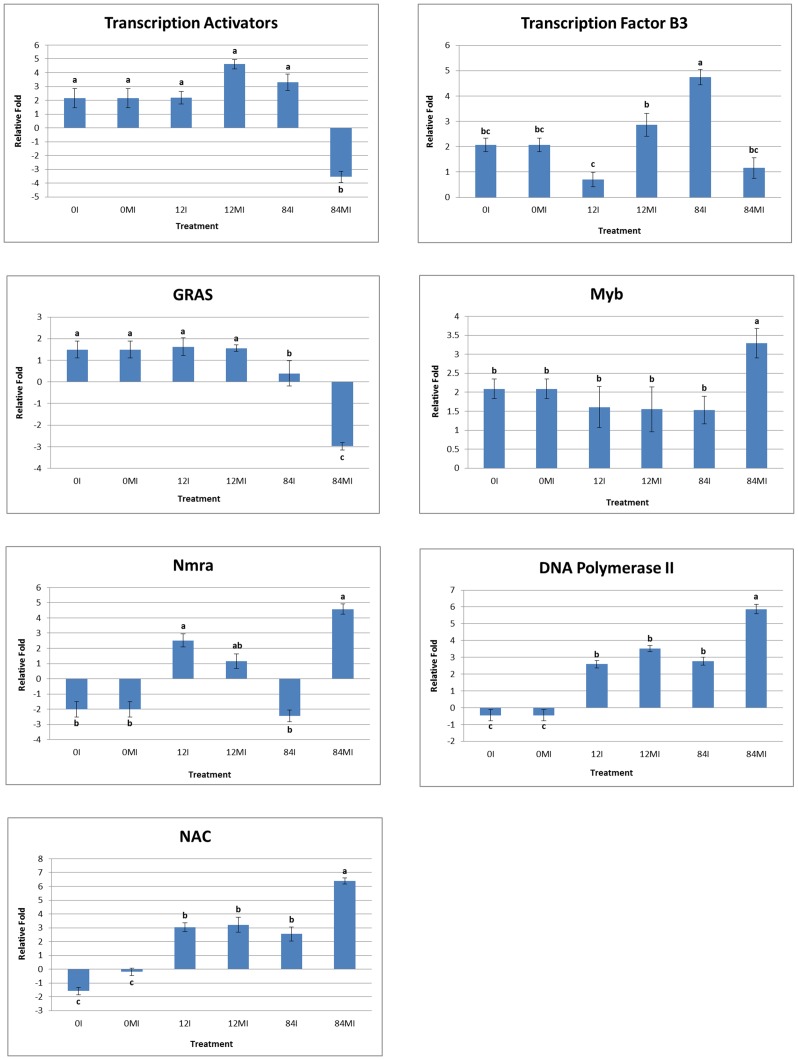
Validation of the relative expression levels of seven selected genes from ChIP-Seq analysis by quantitative Real-Time RT-PCR (qPCR).Expression pattern of selected common bean genes in mock-inoculated and rust-inoculated leaf samples at different time points. The x-axis shows different time point and y-axis shows relative fold change value (Log2FC). Different alphabets in this Figure indicate statistically significant (p-value<0.05) difference in relative expression of each gene between different time points (0, 12, 84 hai) for both inoculated and mock-inoculated leaf samples. The qPCR results from two technical replicates were subjected to ANOVA by using Minitab17 software.